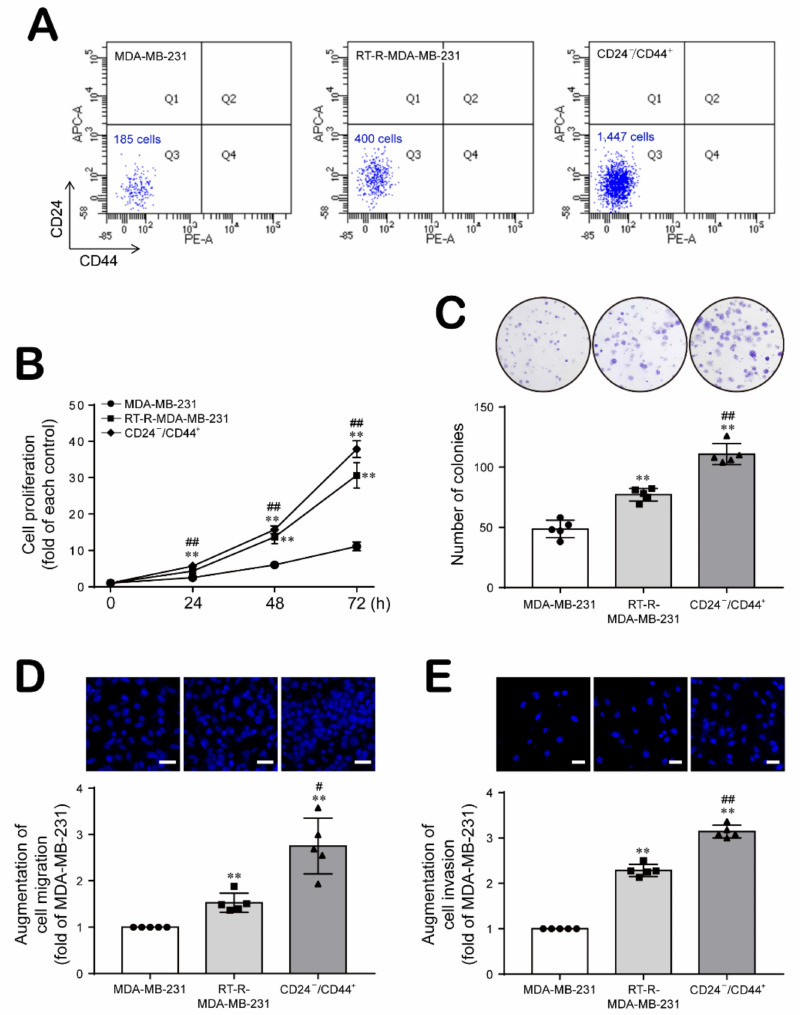
Figure 1. The larger population of CD24 − /low /CD44 + BCSCs in RT-R-breast cancer cells shows increased proliferation, colony formation, migration and invasion abilities. ( A ) CD24 − /low /CD44 + BCSCs were isolated from RT-R-MDA-MB-231 cells as described in the Materials and Methods section, and the CD24 − /low /CD44 + BCSC populations among MDA-MB-231 and RT-R-MDA-MB-231